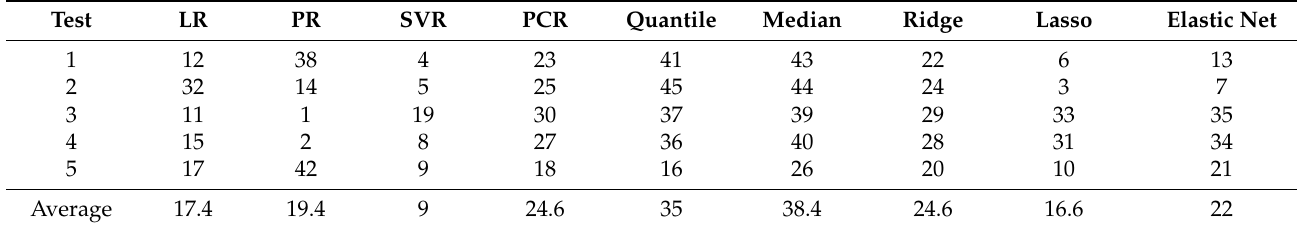
Table 6. Friedman aligned ranks for Ra values in turning.